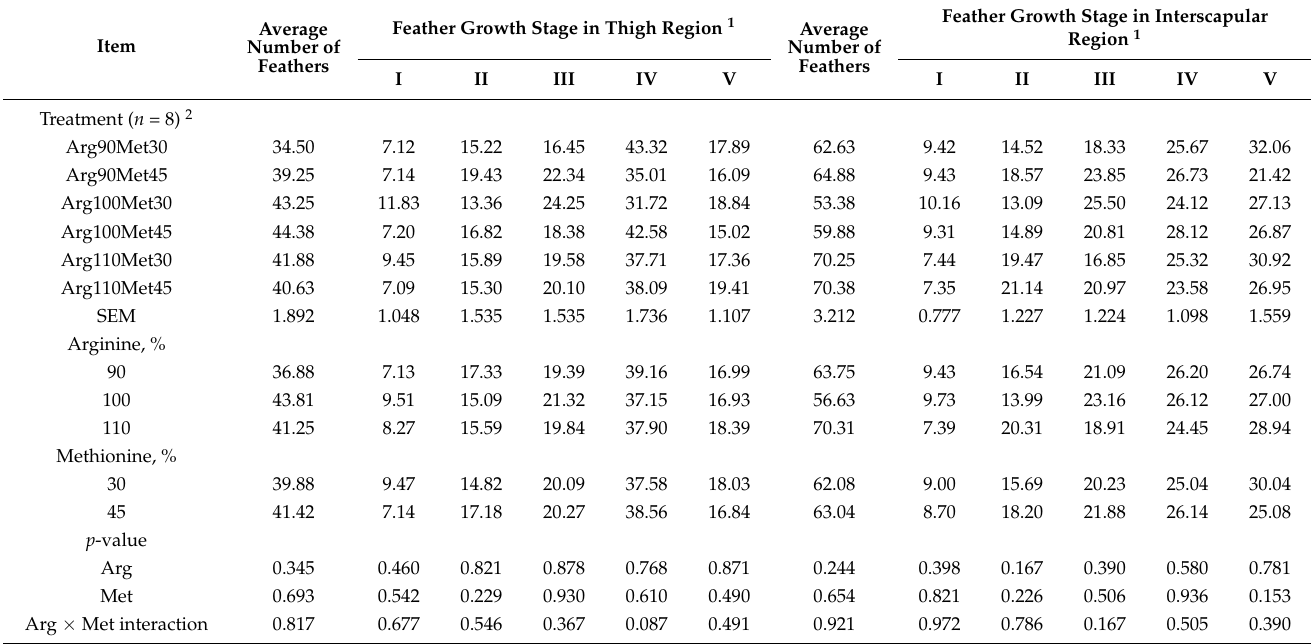
Table 2. Proportions of thigh and interscapular feathers (separately) in different growth stages in 4-week-old